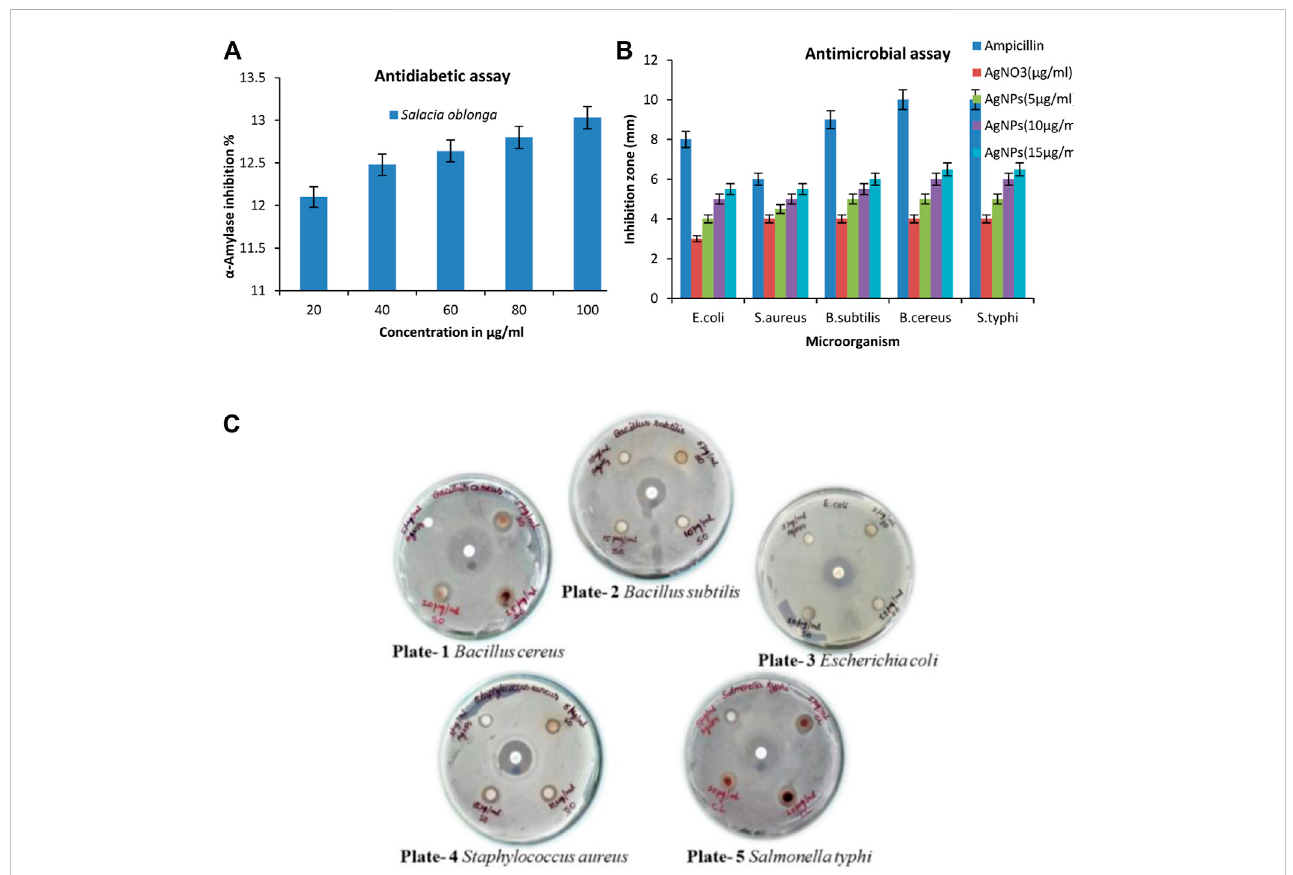
FIGURE 9 (A) In vitro antidiabetic activity( α -amylaseassay) bySOR-AgNPs. 20 – 100 μ g/mL of SOR-AgNPs werepre-incubated with α -amylase(1U/mL) at37 ° C for 20 min. After incubation, 1% starch solution was added to the tubes and incubated at 37 ° C for 15 min. Absorbance was measured at 540 nm and inhibition activity was calculated and represented as Mean ± SD ( n = 3); (B) Graph of antimicrobial assay of the SOR-AgNPs. Inoculums (150 × 10 4 CFU/mL) were swabbed uniformly onto nutrient agar plates, and a 6 mm sterile disc was loaded with various concentrations of SOR-AgNPs. The Petri dishes were then incubated at 26 ° C for 48 h to calculate the inhibition zone and values signi fi ed as Mean ± SD ( n = 3); (C) Evaluation of the antibacterial potential SOR-AgNPs. Plate -1: Bacillus cereus [a) Standard antibiotic, b) 5 μ g/mL AgNPs, c) 5 μ g/mL SOR, d) 15 μ g/mL SOR e) 10 μ g/mL SOR]. Plate -2: Bacillus subtilis [a) Standard antibiotic,b)5 μ g/mLAgNPs,c)5 μ g/mLSOR,d)10 μ g/mLSORe)15 μ g/mLSOR].Plate-3: Escherichiacoli [a)Standardantibiotic,b)5 μ g/mLAgNPs,c)5 μ